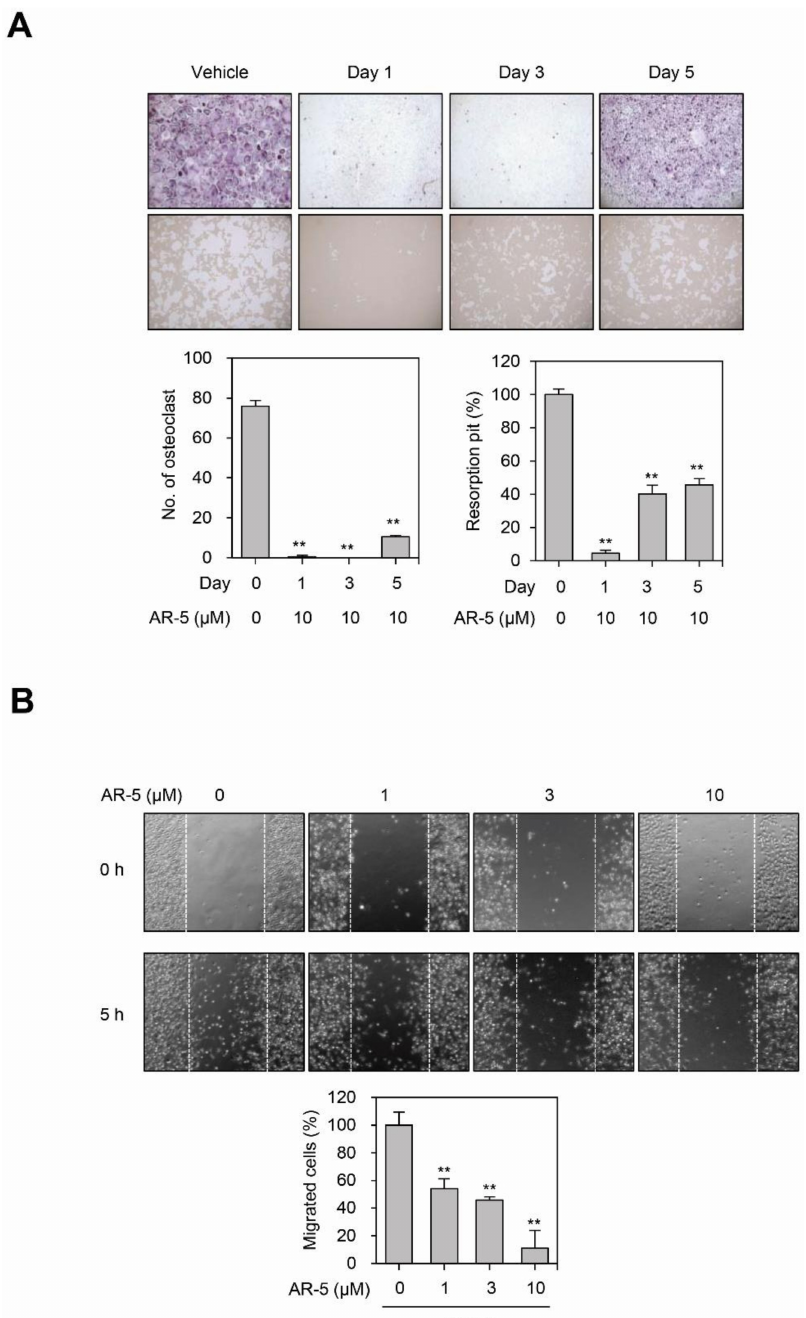
Figure 6. AR-5 inhibits RANKL-induced osteoclast formation at an early and late stage of di ff erentiation. ( A ) BMMs were incubated with M-CSF and RANKL, and then treated with AR-5 (10 µ M) at day 1, 3, and 5 after RANKL stimulation. After incubating for seven days, TRAP staining (upper panel) and bone resorption assay (lower panel) were performed. Data are presented as the mean ± SE (** p < 0.01, versus vehicle-treated control; n = 3). ( B ) E ff ect of AR-5 on RANKL-induced migration of BMMs. After wounds were made, BMMs were stimulated with M-CSF and RANKL in the presence of the indicated concentration of AR-5. Data are presented as the mean ± SE (** p < 0.01, versus vehicle-treated control; n =